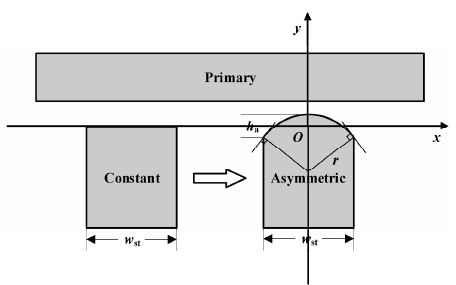
Figure 2. Structure of constant and non ‐ uniform air gap.